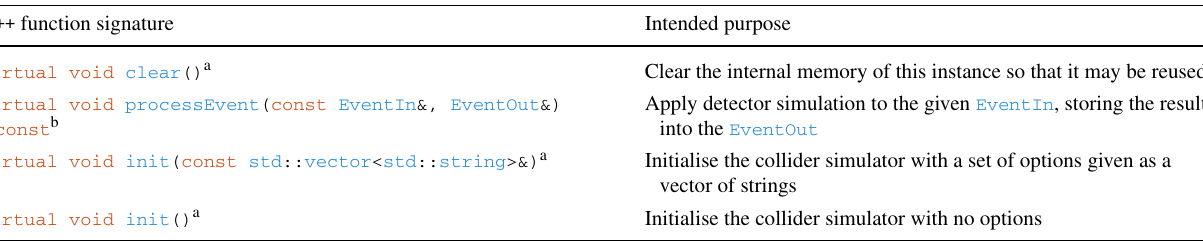
Table 16 Inherited functions for subclasses of BaseDetector<EventIn, EventOut> . Functions marked with a do nothing unless overridden by the subclass author. Functions marked with b must be overridden by the subclass